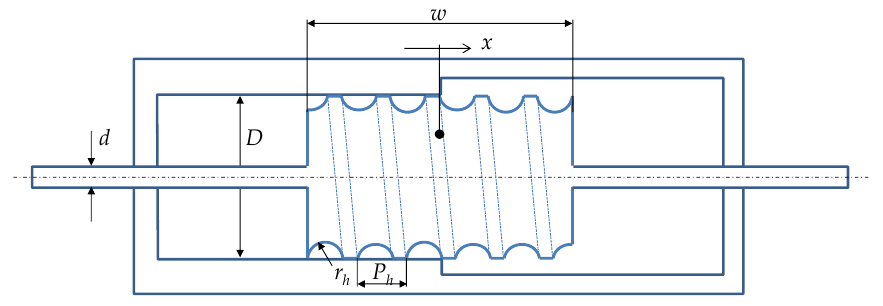
Figure 2. Fluid meminerter according to [27].